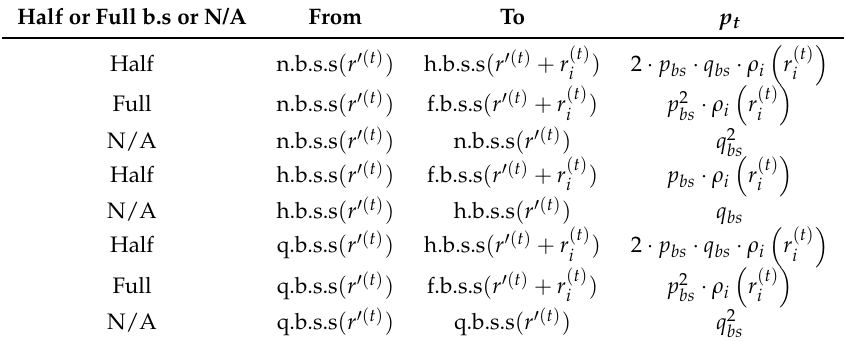
Table 3. Transition table between four chunk states for the updating process with